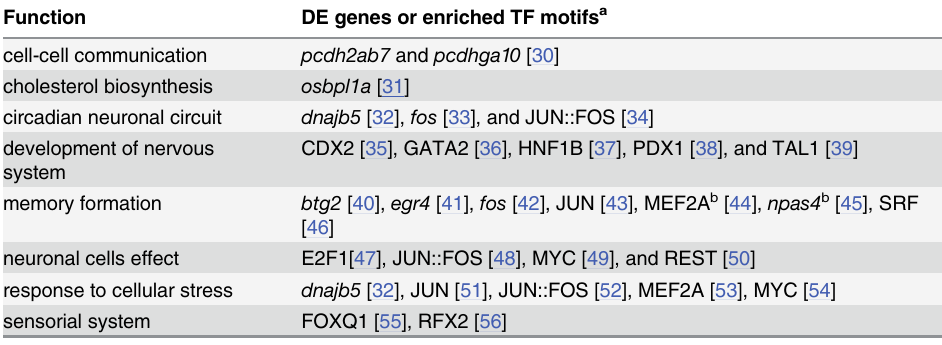
DE gene is represented in italicized small caps, TF motif is represented in all caps